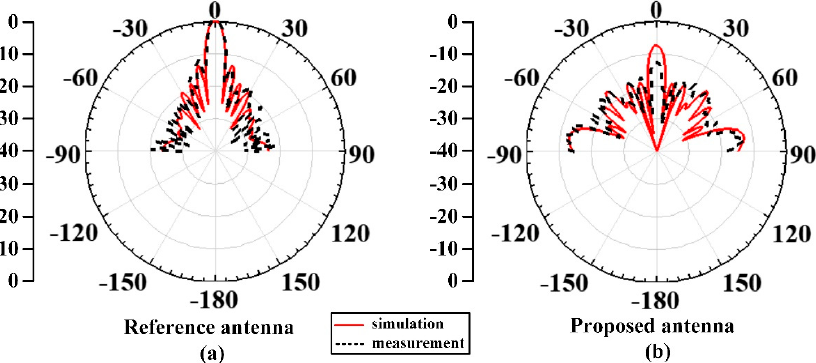
Figure 10. Normalized angular performance of monostatic RCS for y–z plane with VP incident wave at 10 GHz. ( a ) Reference antenna. ( b ) Proposed antenna.